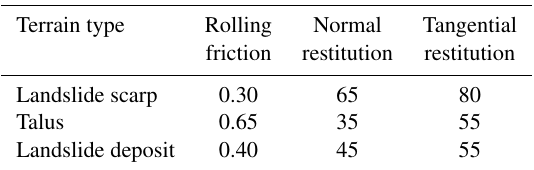
Table 1. Values of the dynamic rolling friction angle and of the nor- mal and tangential energy restitution coefficients assigned to differ- ent terrain